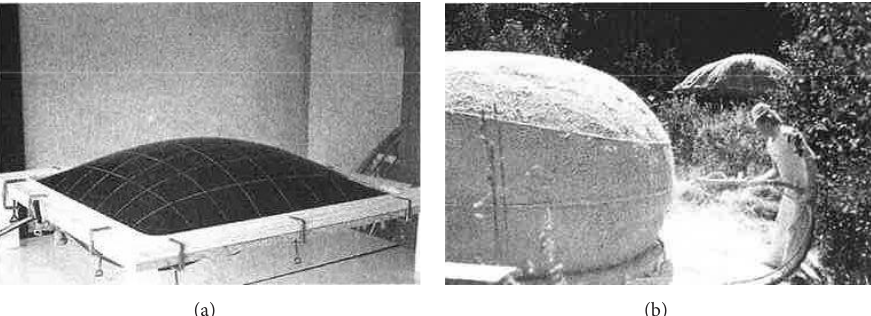
Figure 10: Form-finding with pneumatic formwork (a) and production of a prototype of a circular house with a gypsum-clay mix (b) by Isler [14].